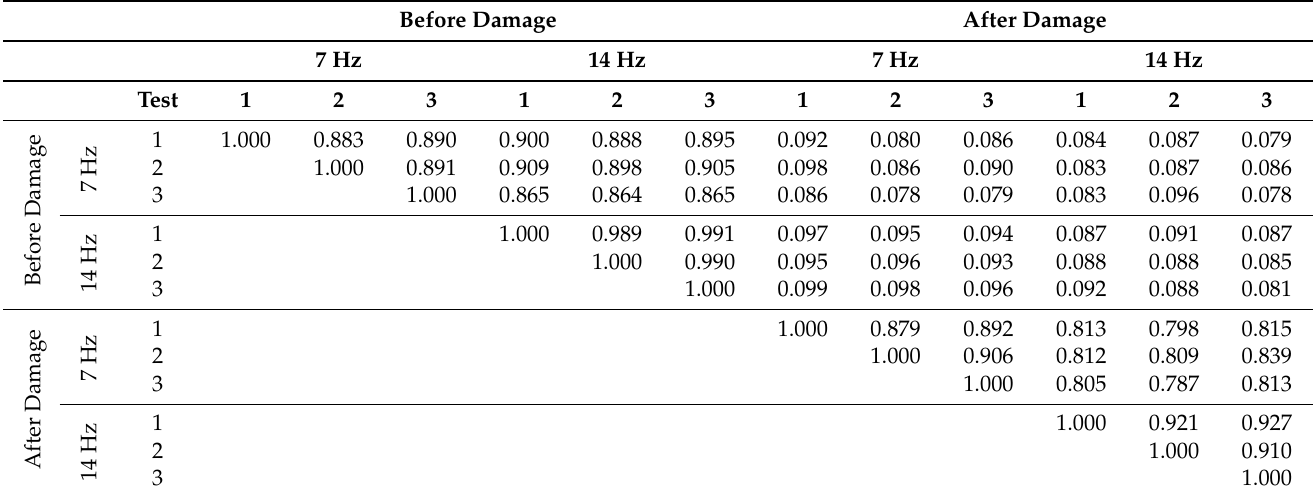
Table 3. Correlation coefficients between BIRFs of the undamaged and damaged structure for the 7 Hz and 14 Hz excitation